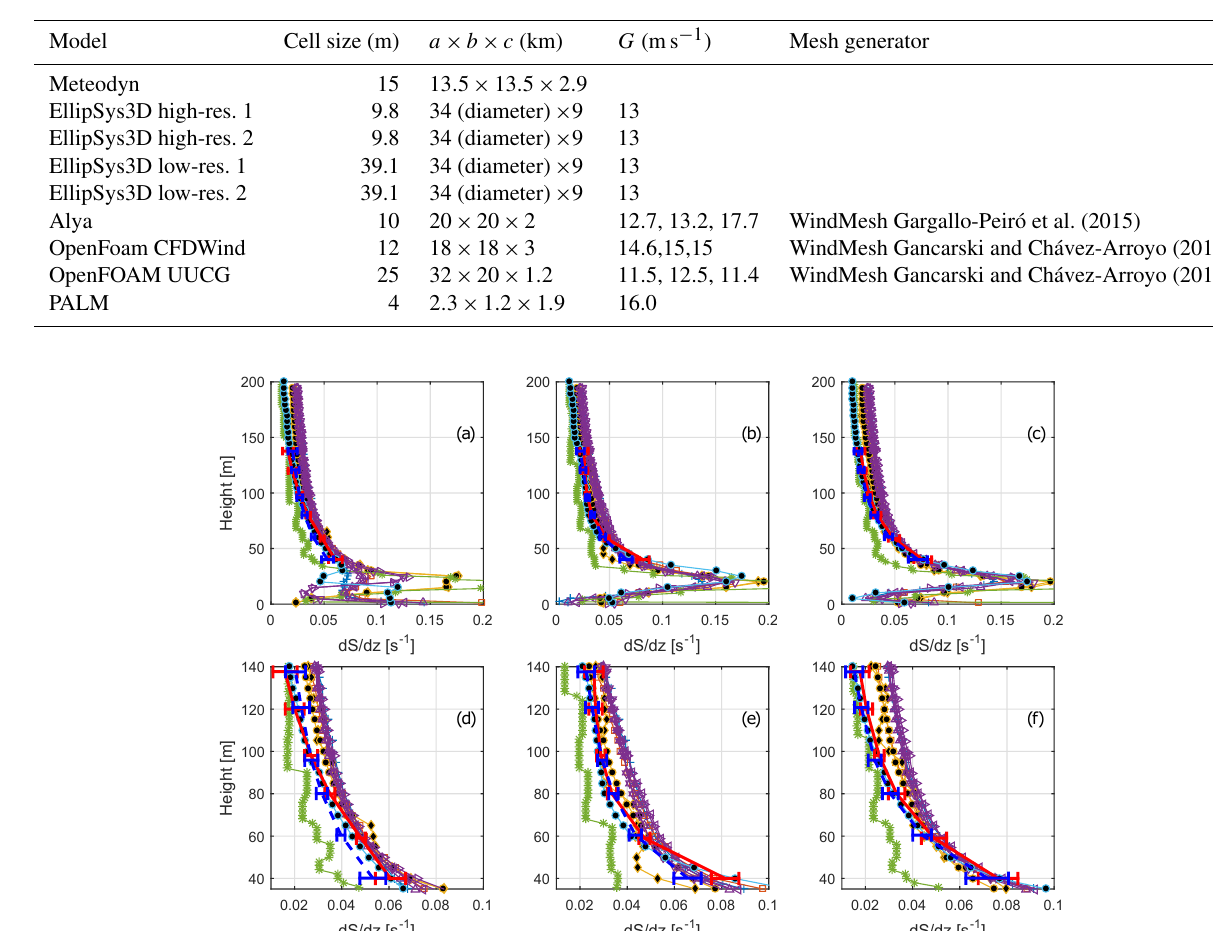
Table 3. Numerical set-up. Cell size refers to the horizontal grid size in the inner domain.